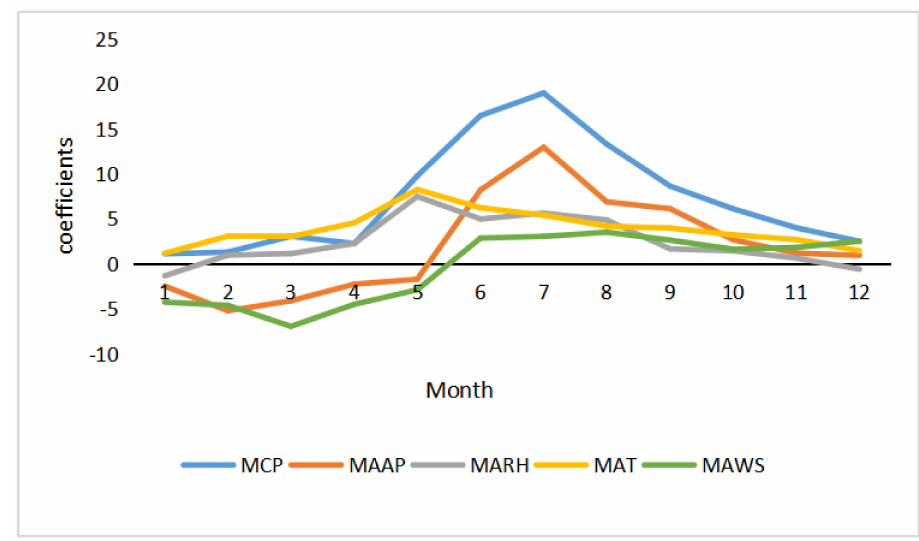
Figure 3. Temporal variations of the coefficients for climate